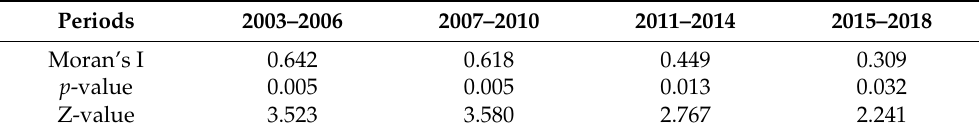
Table 3. Spatial autocorrelation coefficient of the CIGTFEE of YREB in four periods.